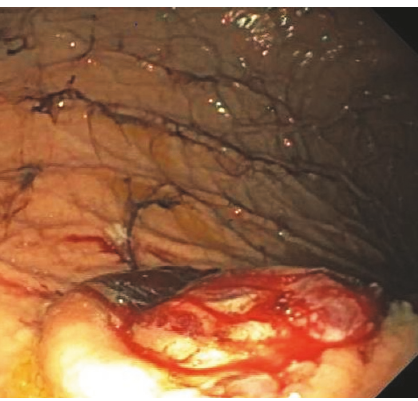
Figure 1: Picture taken from EGD showing a 50mm bleeding mass with an ulcerated center from which biopsies were taken.